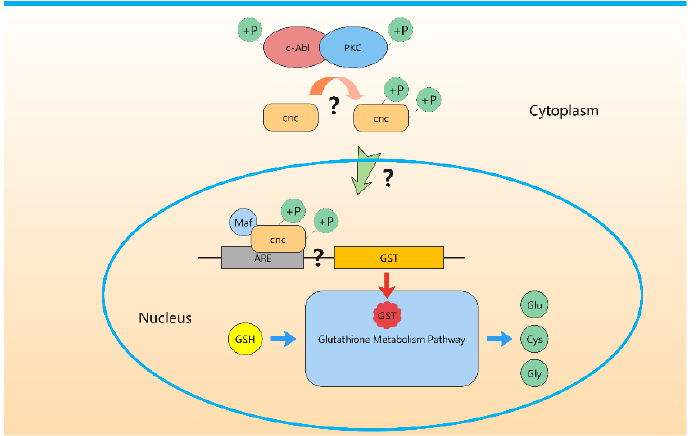
Figure 7. Potential pathway of GST activated by Abl1 to degrade GSH into Gly. “?” indicates the inferred pathway from the literature.